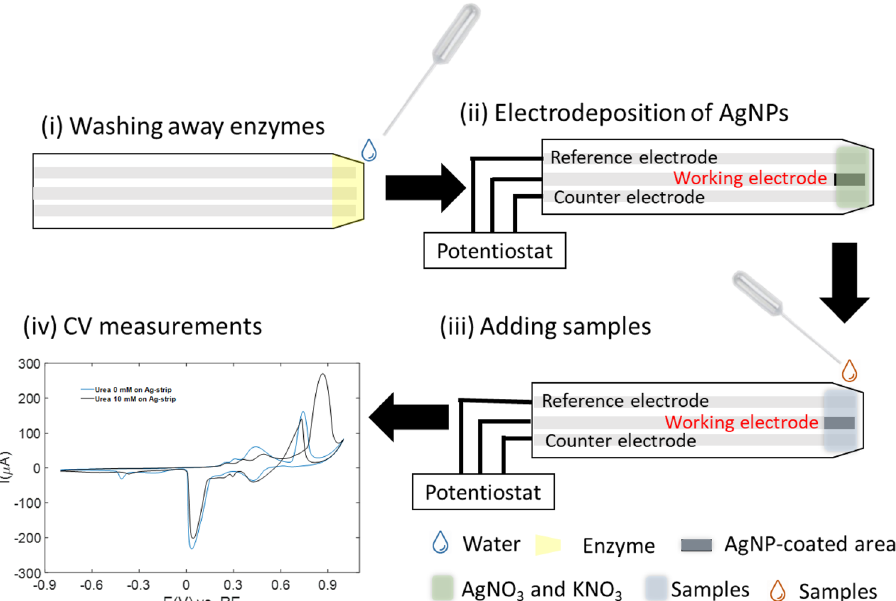
at − 0.6 V for 30 s between the working and reference electrodes in presence of AgNO 3 and KNO 3 . (iii) drop casting of the sample on the sensing area of the test strip for detection. (iv) EC measurements.